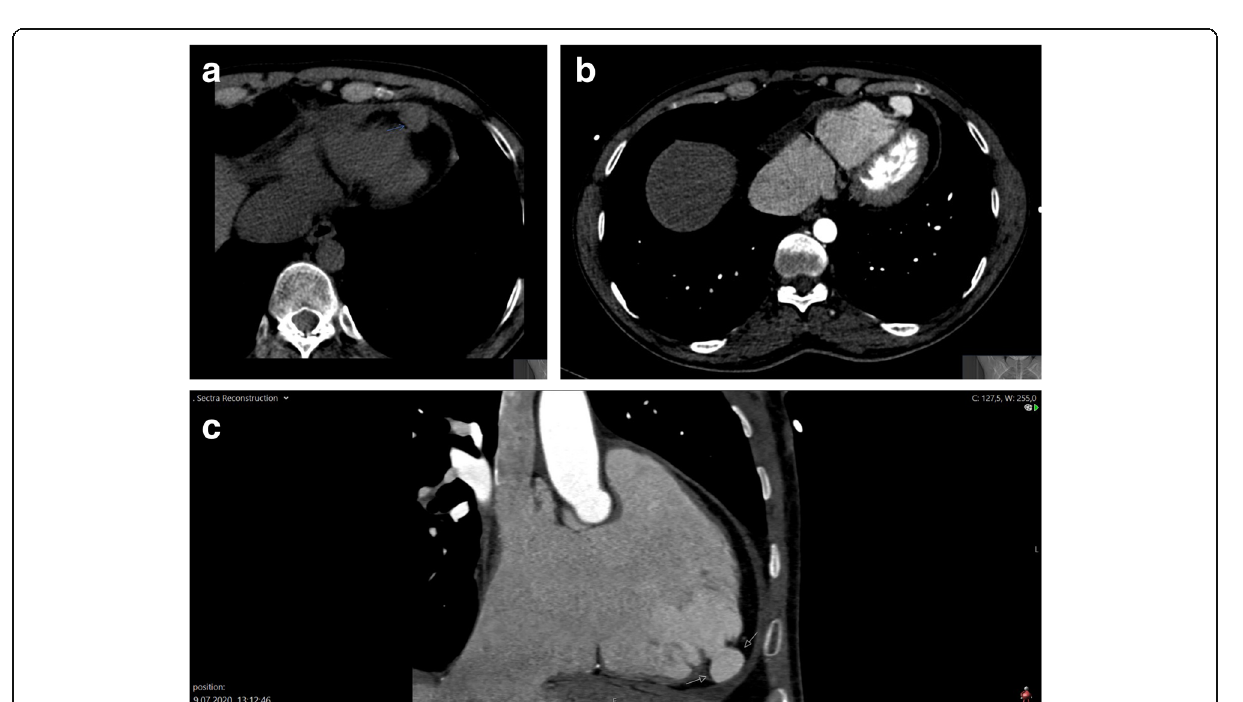
Fig. 1 a Pre-contrast gated CT angiogram shows a small outpouching from the right ventricle apex into the pericardial space, connected through a small neck to the ventricle. b Post-contrast gated CT angiogram shows a small outpouching from the right ventricle apex into the pericardial space, connected through a small neck to the ventricle. c Reconstructed gated CT image shows a small outpouching from the right ventricle apex into the pericardial space, connected through a small neck to the ventricle with minimal pericardial effusion adjacent to the right ventricle